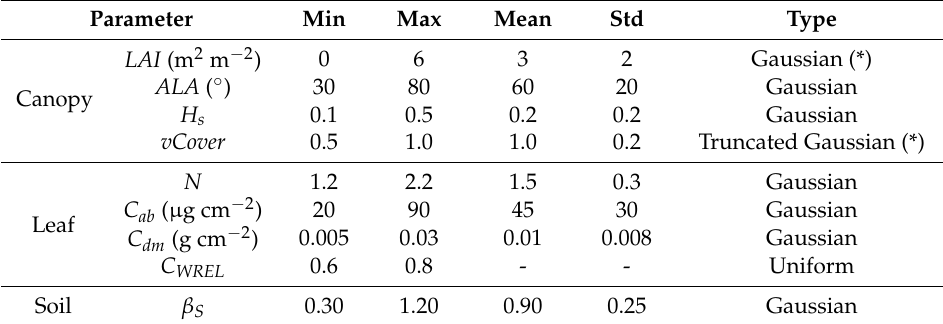
Table 1. Distribution of the PROSAIL parameters used for the simulation of rice reflectance. Parameter Min Max Mean Std Type LAI (m 2 m − 2 ) Canopy